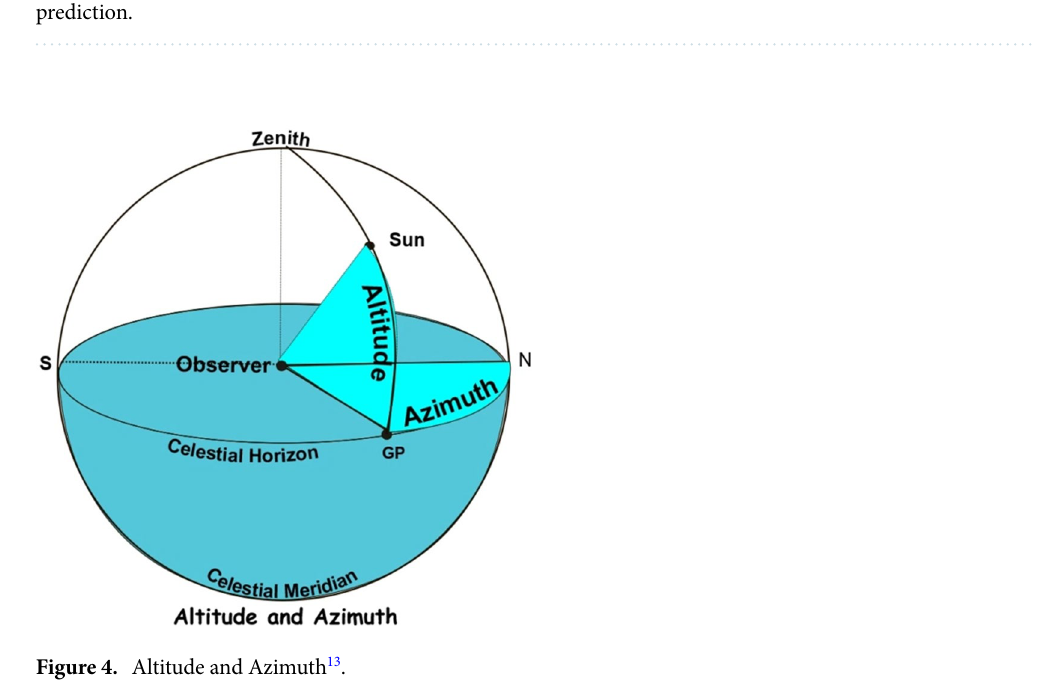
Figure 4. Altitude and Azimuth 13